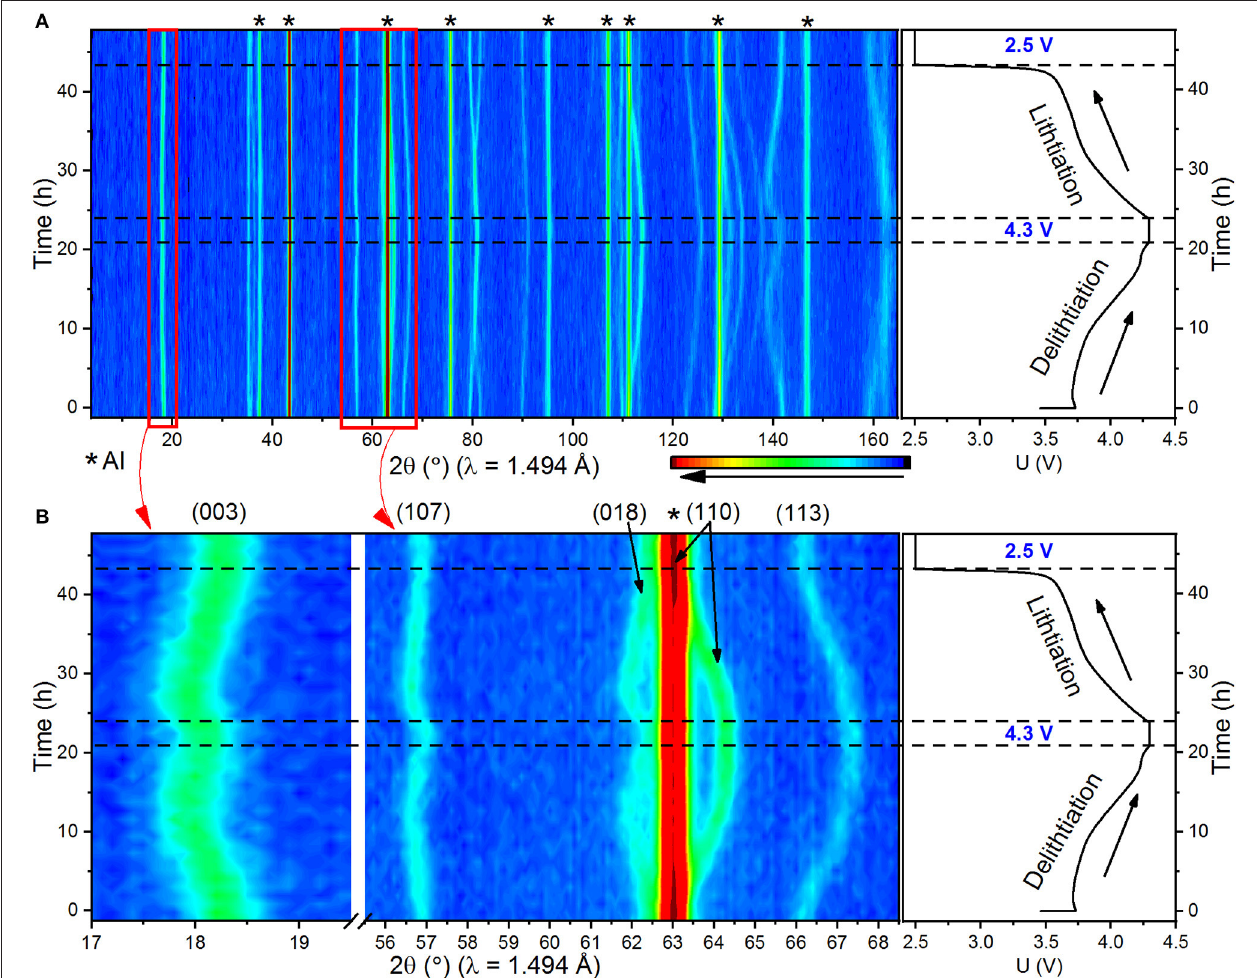
FIGURE 6 | (A) Contour plot representation of the operando neutron diffraction data alongside the electrochemical curve obtained during the cycling of the cylindrical cell with NCM622 as the active material. (B) Enlargements of the contour plot highlight the evolution of (003) and (110) reflections of the active